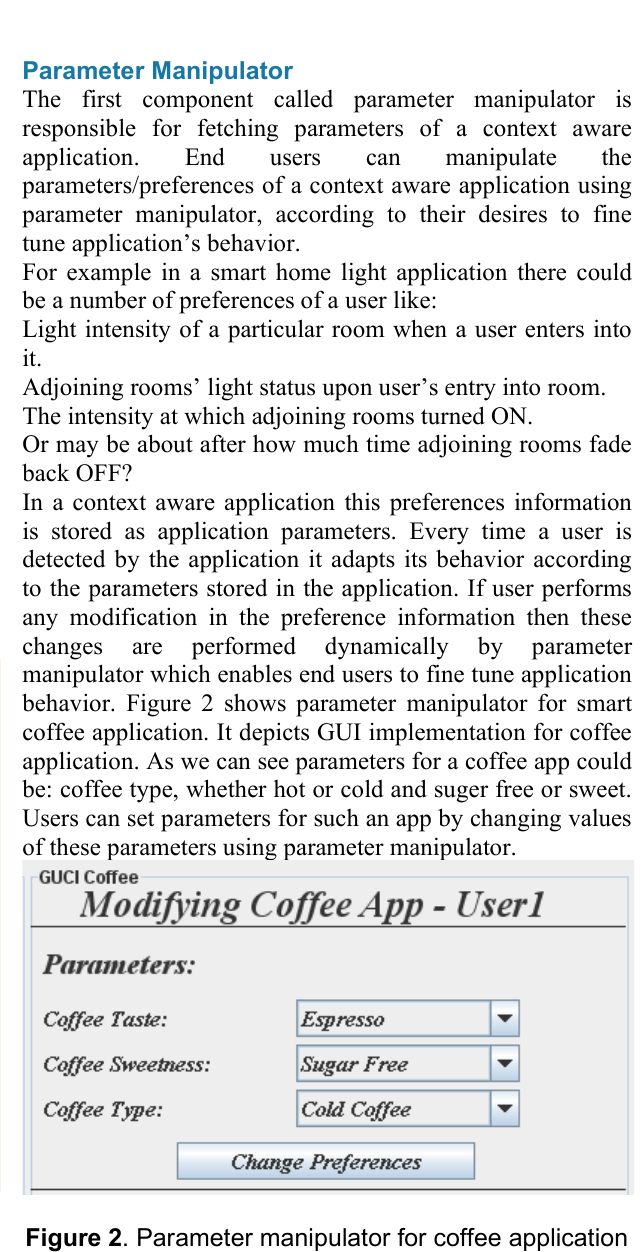
Figure 2 . Parameter manipulator for coffee application Adaptation Logic